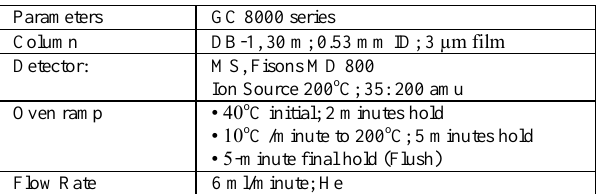
Table 4. Gas-chromatographic parameters used for detection of C 5 –C 11 compounds Parameters